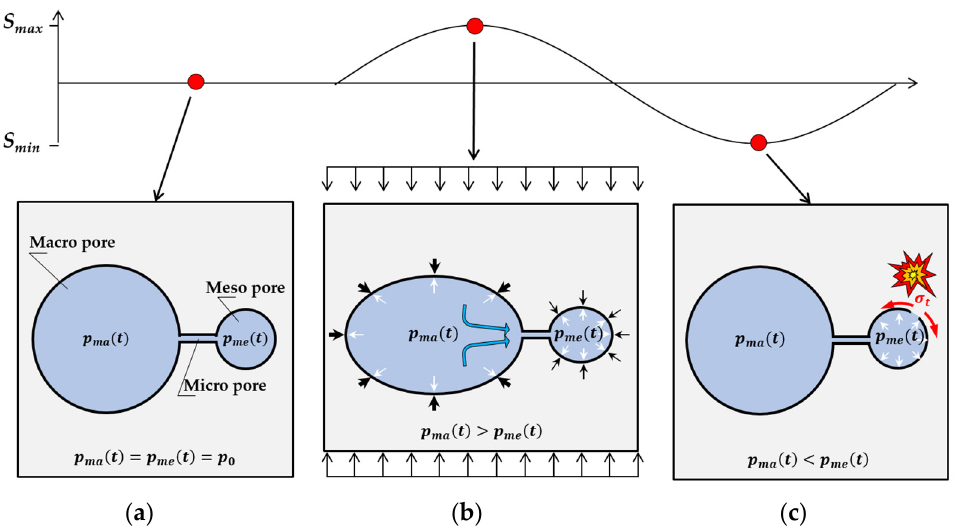
Figure 6. Descriptive model for water-induced damage due to cyclic loading: ( a ) first status (mean stress level); ( b ) second status (maximum stress level); ( c ) third status (minimum stress level) [22].